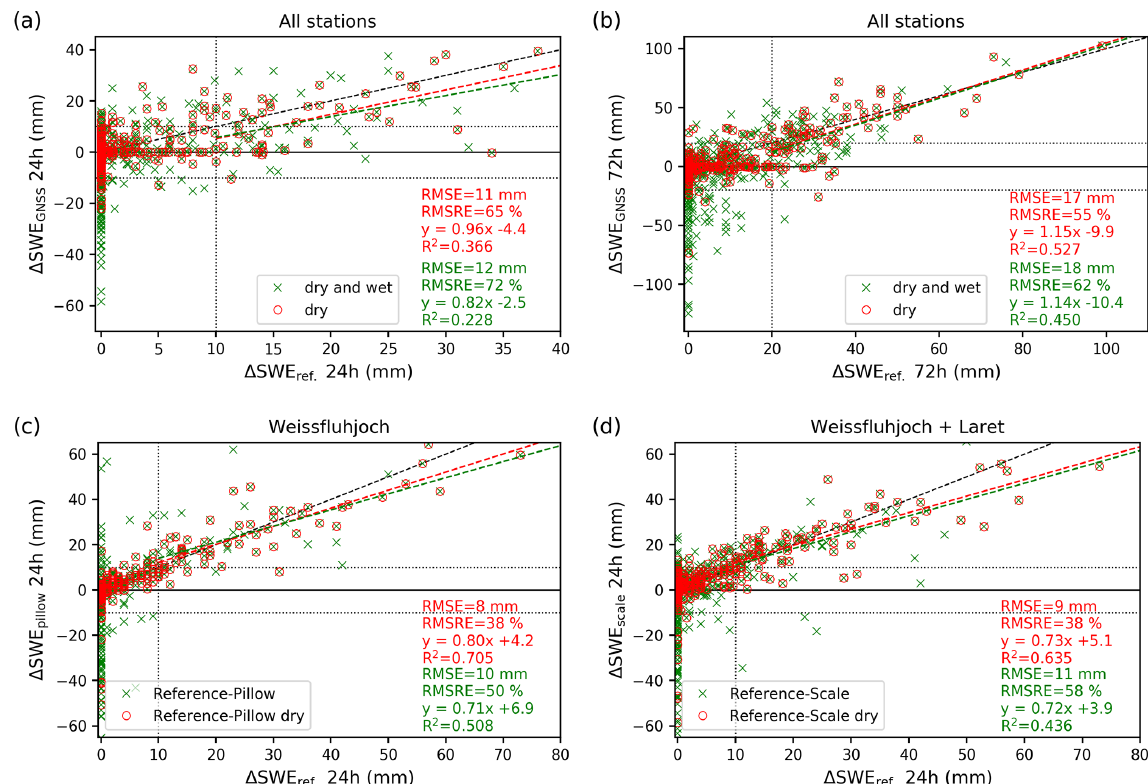
Figure 5. Changes in GNSS-derived SWE vs. new snow water equivalent from reference measurements (pluviometer or observer) for all stations and for winter 2019–2020: (a) over 24h and (b) over 72h. Changes in SWE obtained with (c) snow pillow (Weissfluhjoch) and (d) snow scale (Weissfluhjoch and Laret) vs. reference measurements for both winters. The dashed lines indicate linear regression for the dry-snow conditions (red) and the entire season (green). The black dashed line indicates the 1 : 1 line. The linear regressions were computed only for data points with (cid:49) SWE ref > 10mm within 24h or (cid:49) SWE ref > 20mm within 72h (dotted